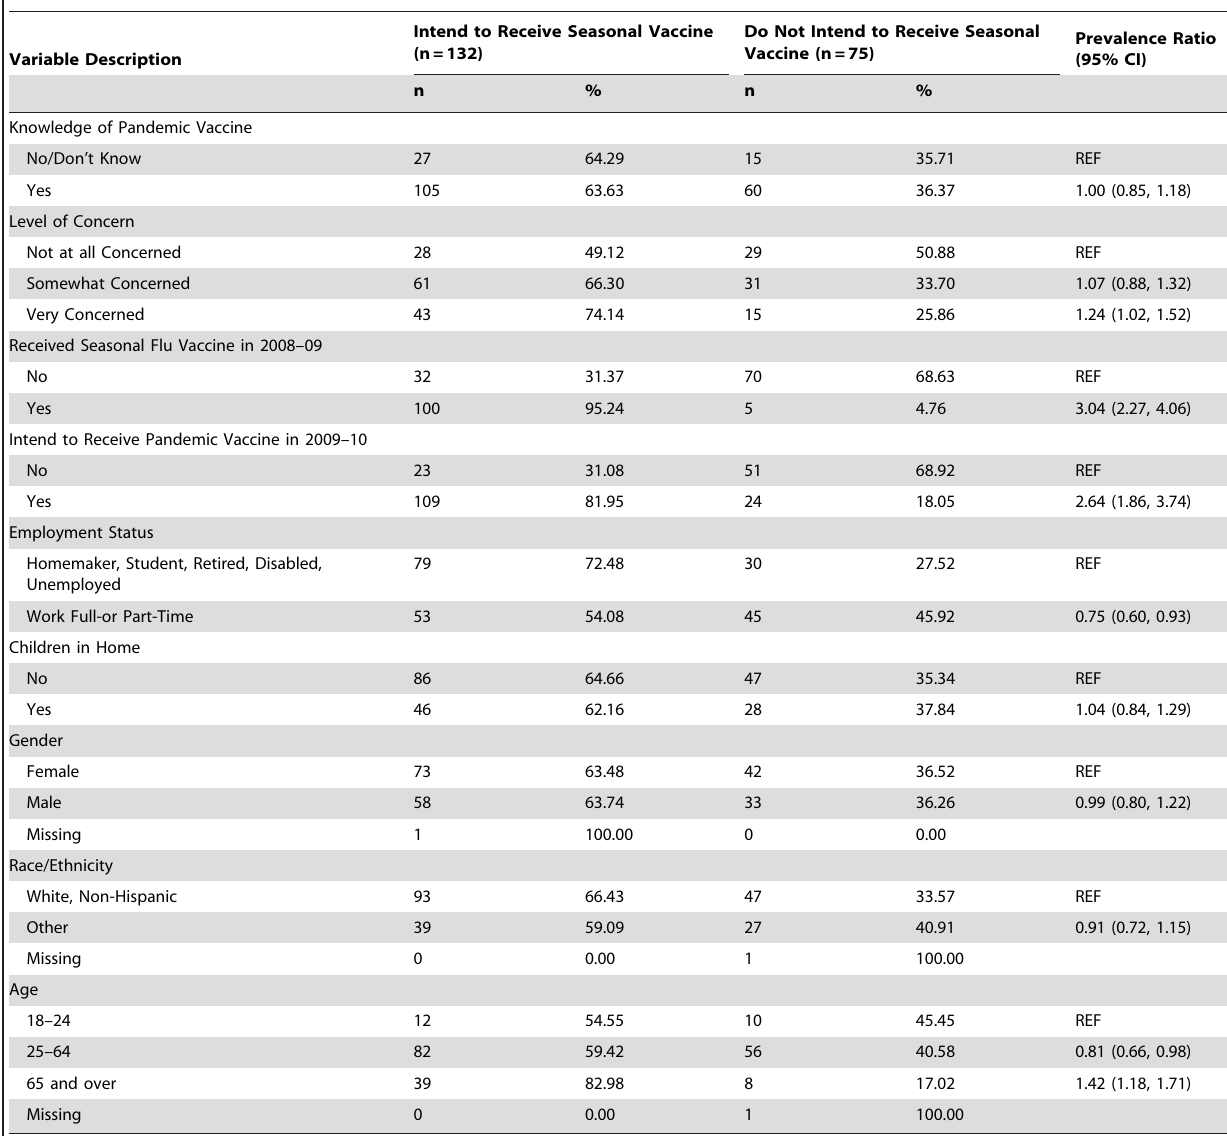
Table 2. Factors potentially associated with intention to receive vaccination for seasonal influenza, North Carolina, 2009 (N =207).